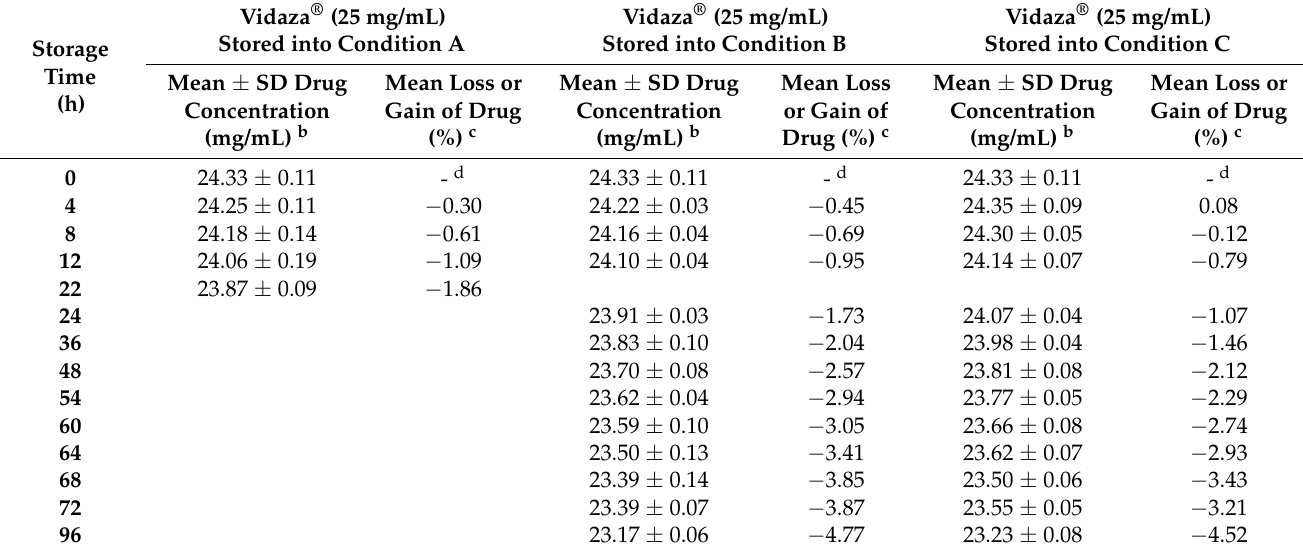
Table 1. Chemical stability of Vidaza ® (25 mg/mL) stored at 2–8 ◦ C in the original container (condition A), in a polypropy- lene syringe (condition B), and in a polypropylene syringe placed between two refrigerant gel packs (condition C).